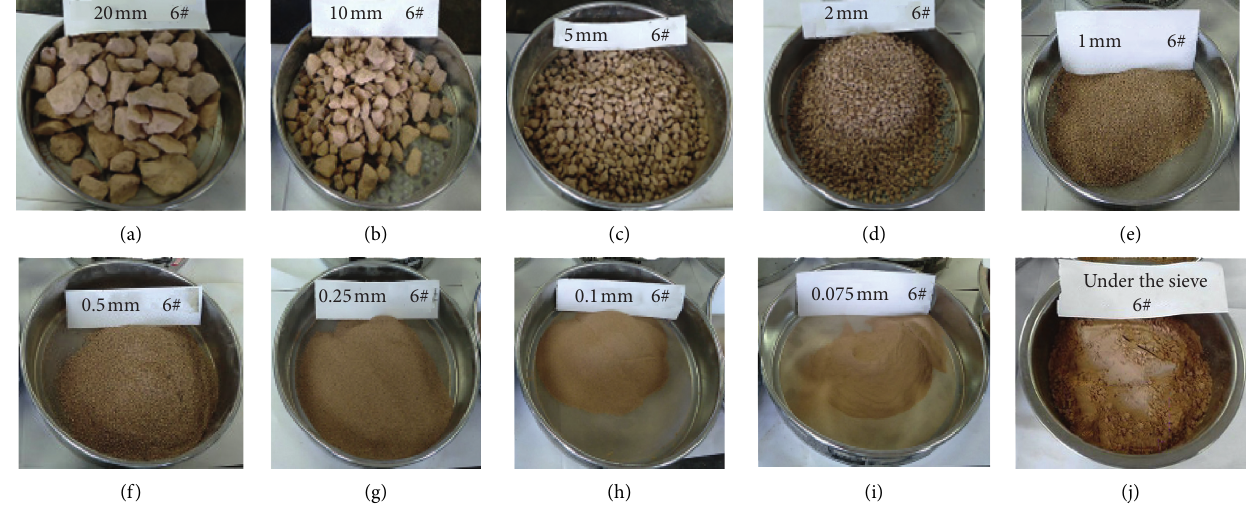
Figure 11: Appearance of the samples on each sieve after the sieving test. Table 2: Required parameters in the ABAQUS numerical